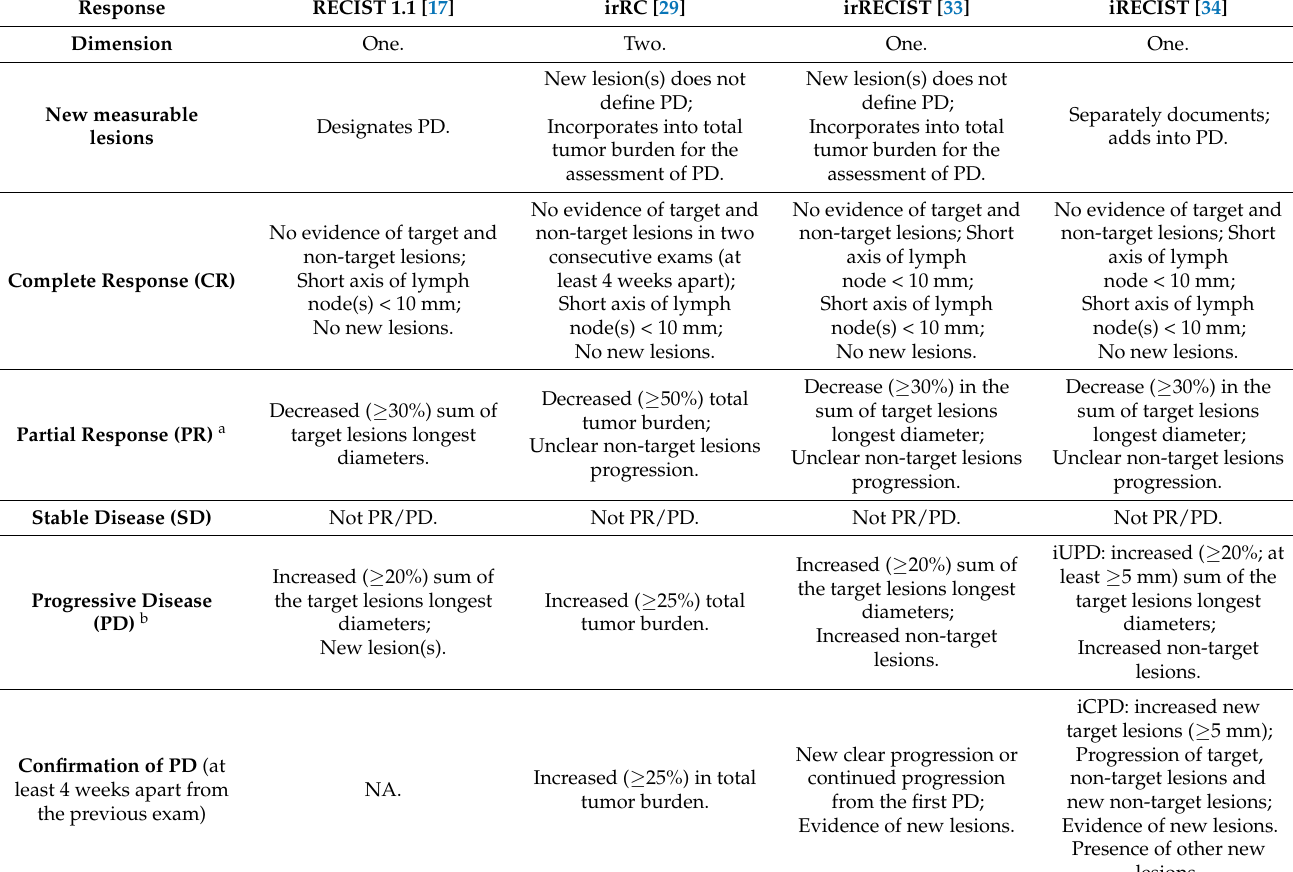
Table 2. Imaging tumor response criteria to